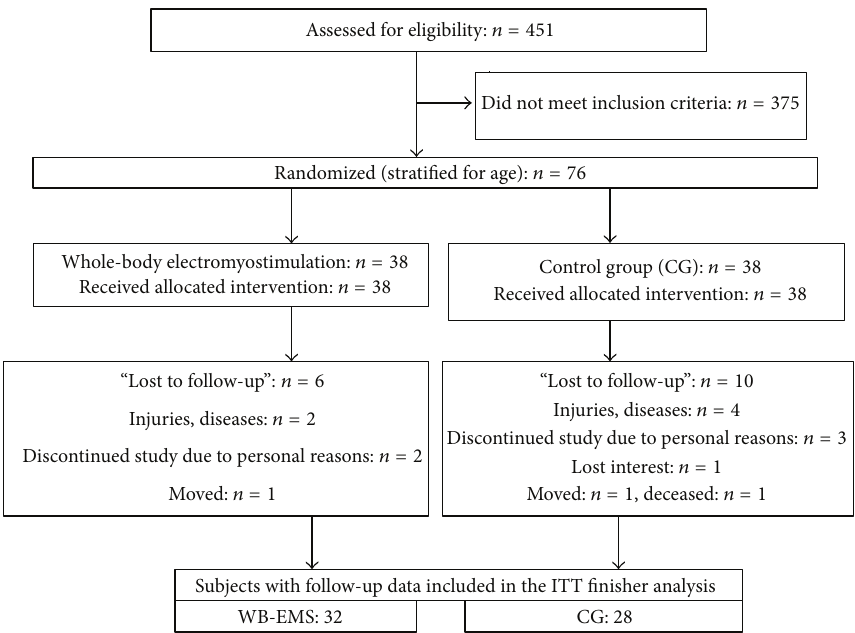
Figure 1: Flow chart of the “TEST-III” study (CONSORT scheme).